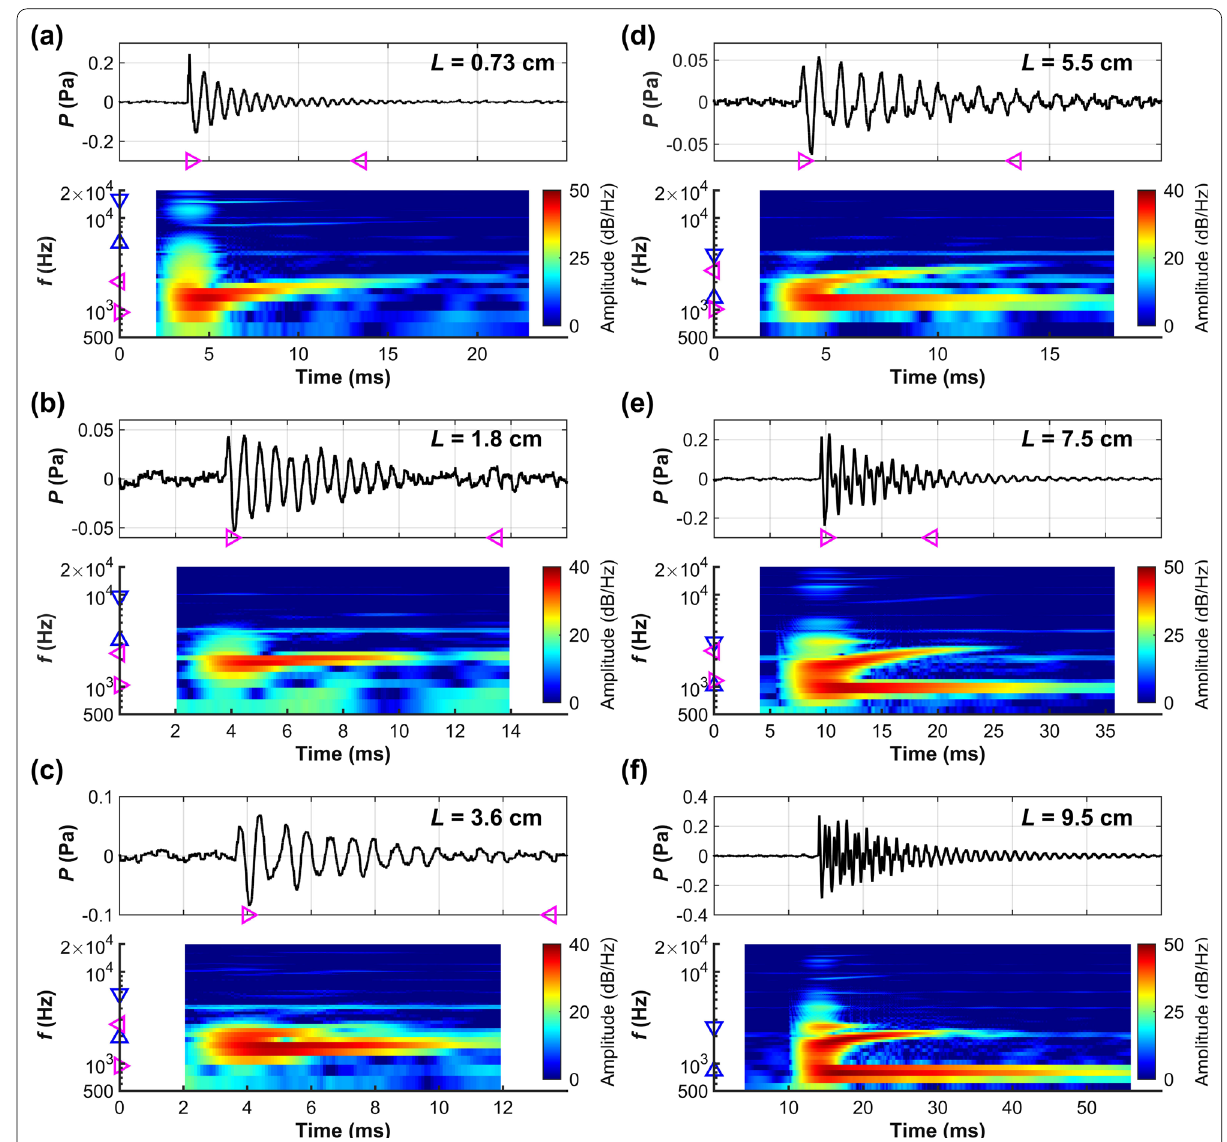
Fig. 14 Waveforms and spectrograms (re 20 µ Pa 2 ) of airwaves excited at varying levels. V = 5 cm 3 bubble bursts in a suspension of φ = 0.4 . Air column lengths L (cm) are annotated (see Additional file 6: Movie 6 and the Graphical Abstract for the images of ( e )). Waveforms are detrended and highpass filtered at 500 Hz. Running windows and overlaps are ( a - d ) 4.096 ms and 4.000 ms, ( e - f ) 8.192 ms and 8.100 ms, respectively. Blue (cid:31) and (cid:31) indicate the f A ( n = 0,1 , respectively) calculated from Eq. (20). Pink ⊲ and ⊳ indicate the f H calculated from Eq. (11) using aperture radii R a measured at the times indicated on the time axis. In ( f ), f H is not calculated because the timing of the aperture opening could not be determined from the